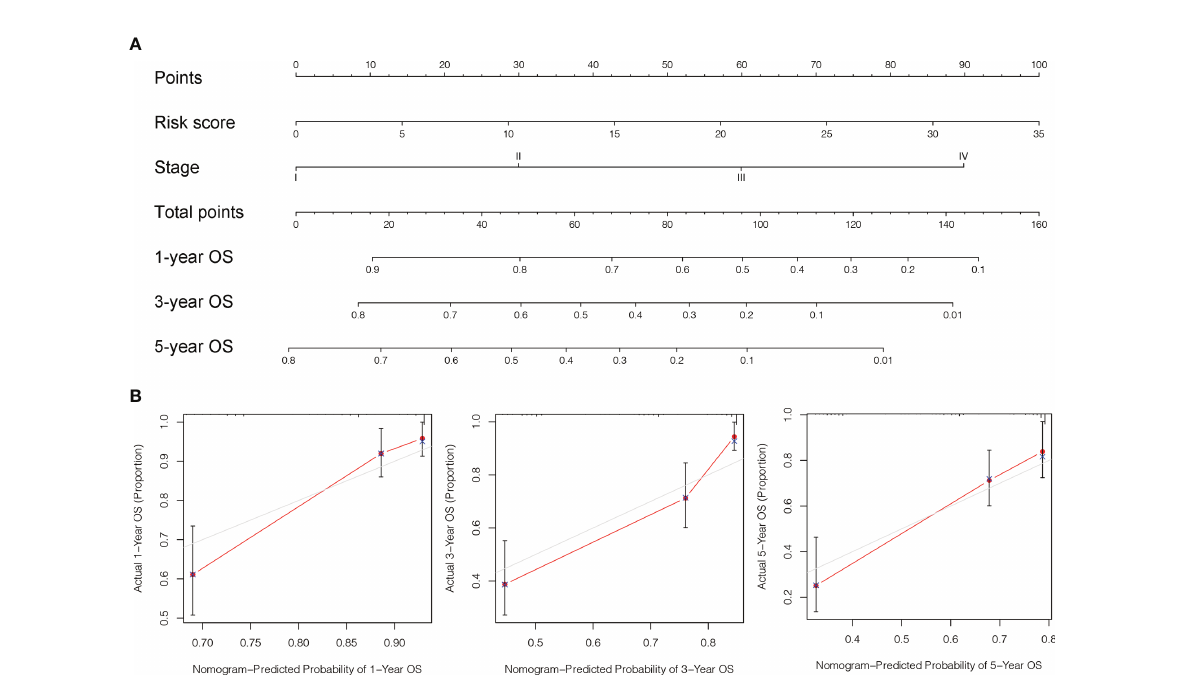
FIGURE 8 Design and validation of the nomogram. (A) A nomogram integrating combining clinio-pathological factors and risk score predicts one, three, and fi ve- years OS of liver cancer individuals. (B) The calibration curves assess consistency among the actual OS rates and the expected survival rates at one-, three- and fi